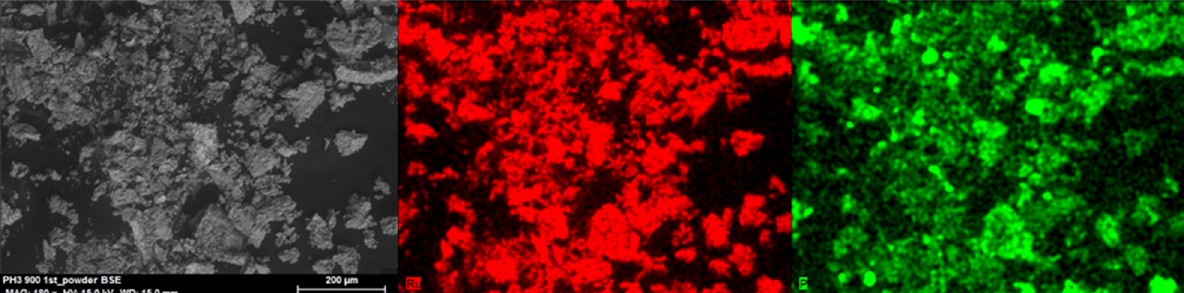
Figure 3. SEM image of the RuO 2 [(PPh 3 )] powder obtained by calcination at 900 °C in static air and the corresponding EDX mapping to evidence the Ru (red) and P (green) distribution.